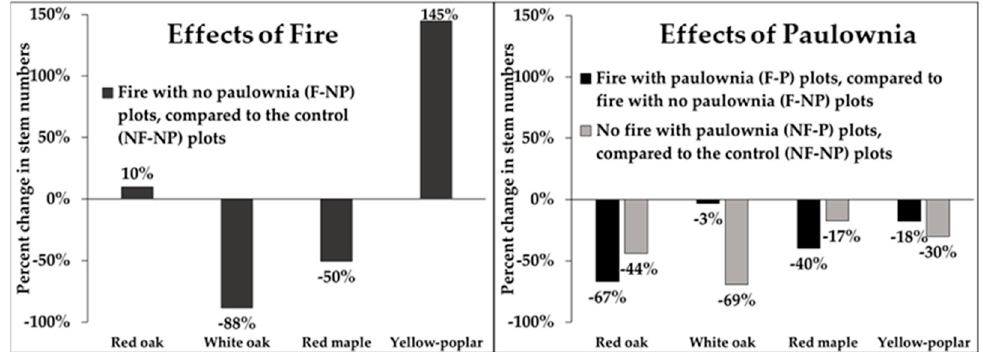
Figure 2. The effects of fire and the presence of paulownia ( Paulownia tomentosa ) two years after wildfire on the percent change in the number of regenerating stems (<137 cm height) of red and white oaks ( Quercus sp.), red maple ( Acer rubrum ), and yellow-poplar ( Liriodendron tulipifera ).